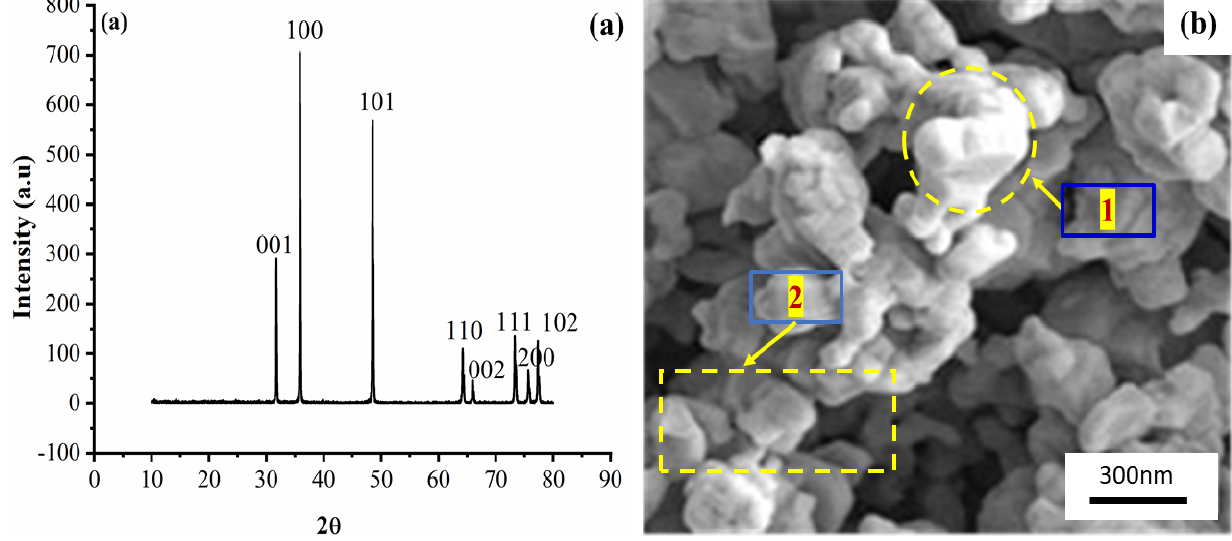
Figure 3. ( a ) XRD pattern and ( b ) SEM image of WC Particle (1 reveals fine and spherical morphology and 2 reveals agglomeration).